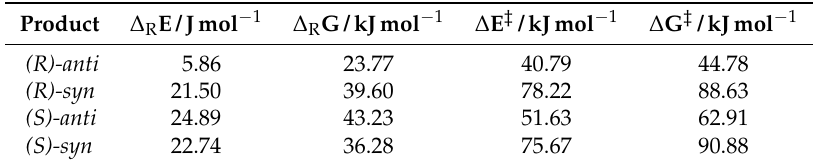
Figure 5. Energy profiles of aldol reactions (R=Et) resulting from static nudged elastic band (NEB) calculations. Energies are given relative to educts. Table 2. Total reaction energies ∆ R E and reaction barriers ∆ E ‡ for the aldol reactions (R=Et) from static NEB calculations; see Figure 5. Free enthalpies ∆ R G and ∆ G ‡ estimated from harmonic frequency calculations at 300K. All energies are given relative to